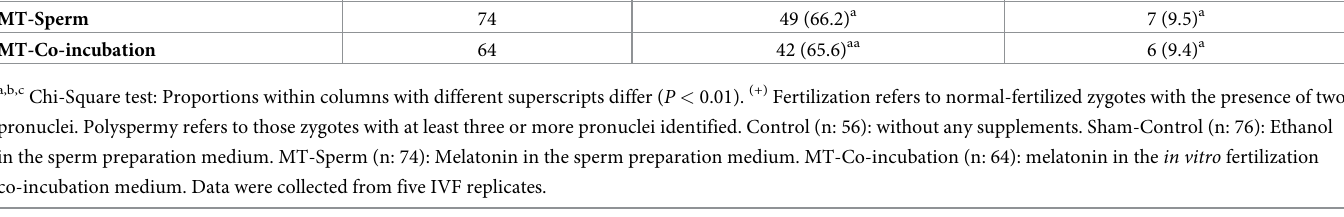
sperm preparation protocol (MT-Sperm: 66.2%) compared to that found in the Control (57.1%) and Sham-Control (43.4%) groups (Table 5) . Similarly, the group MT-Co-incubation had a greater proportion of regularly fertilized COCs than Sham-Control (65.6% vs. 43.4%, respectively), but not ( P > 0.05) when compared with the Control or MT-Sperm (65.6% vs. Table 5. Effect of melatonin addition to the IVF protocol on in vitro fertilization and polyspermy rates. Treatment Group Zygotes ( n